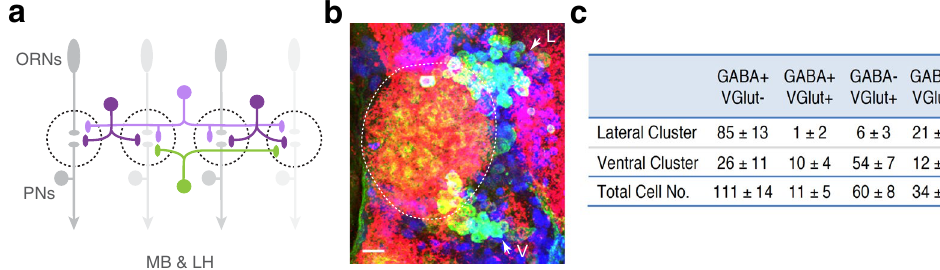
Figure 1. Drosophila LN network exhibits high ratio of inhibitory to excitatory neurons. ( a ) Schematic of the Drosophila olfactory system. Dashed circles denote individual glomeruli in the AL, where axons of ORN (gray ovals), dendrites of PNs (gray circles), and the processes of excitatory LNs (green) and inhibitory LNs (magenta) form extensive synaptic connections. Different shades of green and magenta represent different types of corresponding neurons. MB, mushroom body. LH, lateral horn. ( b ) Adult fly brains were stained with anti-GABA (blue), anti-VGlut (red), and anti-mCD8 (green) antibodies to visualize GABAergic, glutamatergic and almost all LNs, respectively. White dashed line contours the AL. Arrows indicate lateral (L) and ventral (V) LN clusters. Scale bar, 10 μ m. ( c ) The table shows estimated numbers of GABA- and/or VGlut-expression LNs within the AL (mean ± SD, n = 5). LNs expressing either GABA, VGlut or both are inhibitory LNs; GABA- negative and VGlut-negative LNs are excitatory